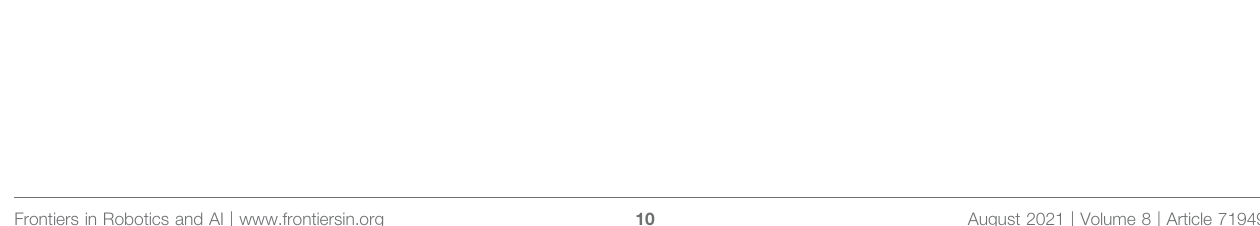
Frontiers in Robotics and AI |